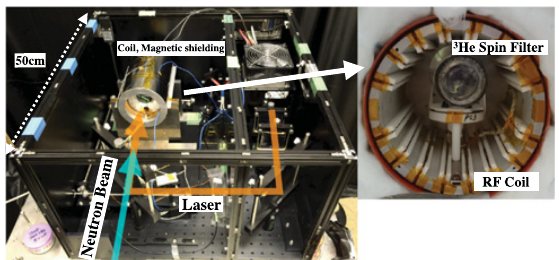
Figure 13. The laser system which can be installed at the neutron beam line. The RF coil is used to flip the polarization of 3 He using the NMR method of adiabatic fast passage